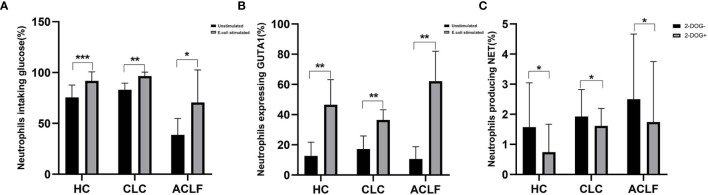
The effect of glycolysis inhibition on neutrophil extracellular trap (NET) formation. (A) The percentage of neutrophils uptaking glucose in patients with hepatitis B virus related acute-on-chronic liver failure (HBV-ACLF) (N=5), compensated liver cirrhosis (CLC) (N=6), and healthy controls (HCs) (N=8) following E. coli stimulation. (B) The percentage of neutrophils expressing Glut1 in patients with HBV-ACLF (N=5), CLC (N=7), and HCs (N=6) following E. coli stimulation. (C) After additional supplement of 2-DOG, the percentage of neutrophils producing NET was determined from patients with HBV-ACLF (N=9), CLC(N=7), and HCs (N=7). Data are expressed as mean ± standard deviation (SD). Statistical analysis was performed by the Mann-Whitney u test. NS, P > 0.05; *0.01 ≤ P < 0.05; **0.001 ≤ P < 0.01; ***P < 0.001.